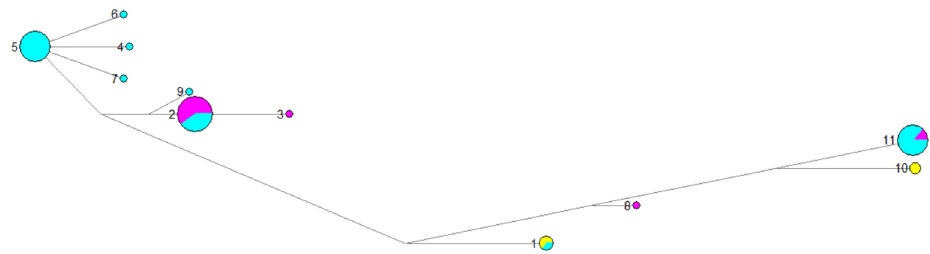
Figure 5. Distribution of 11 chloroplast haplotypes detected in P. suffruticosa. Note: 1-11: haplotype 1-11; yellow color: Jiangnan group; purple color: Xibei group; blue color: Zhongyuan group.